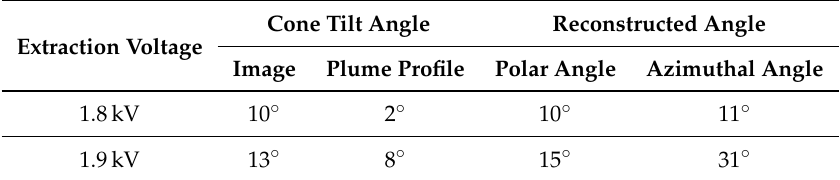
Table 2. Cone Tilt Reconstruction Values.